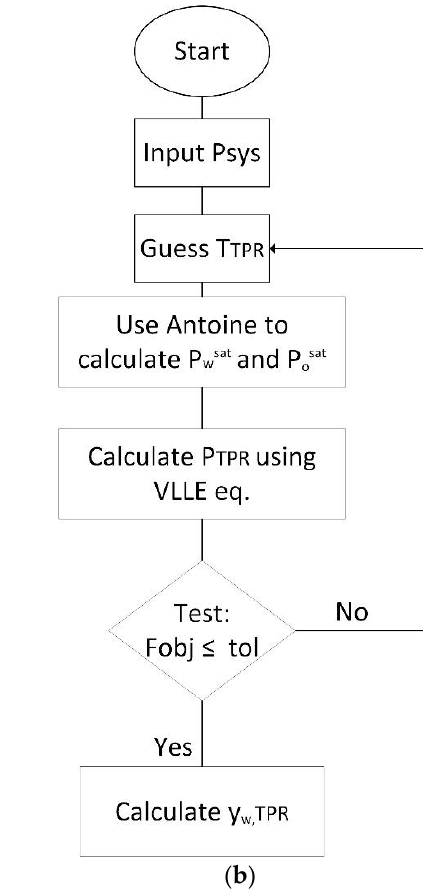
Figure 2. Algorithm for Three Phase Region (TPR): ( a ) Calculations at a fixed T and ( b ) Calculations at a fixed P.